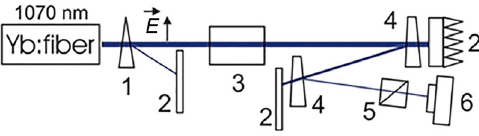
Fig. 5 Scheme of the experiment for the study of thermally induced depolarization: 1-calcite wedge polarizer, 2-absorber, 3-sample, 4-fused quartz wedge, 5-Glan prism,  and 6-CCD camera; E -electrically induced magnetic